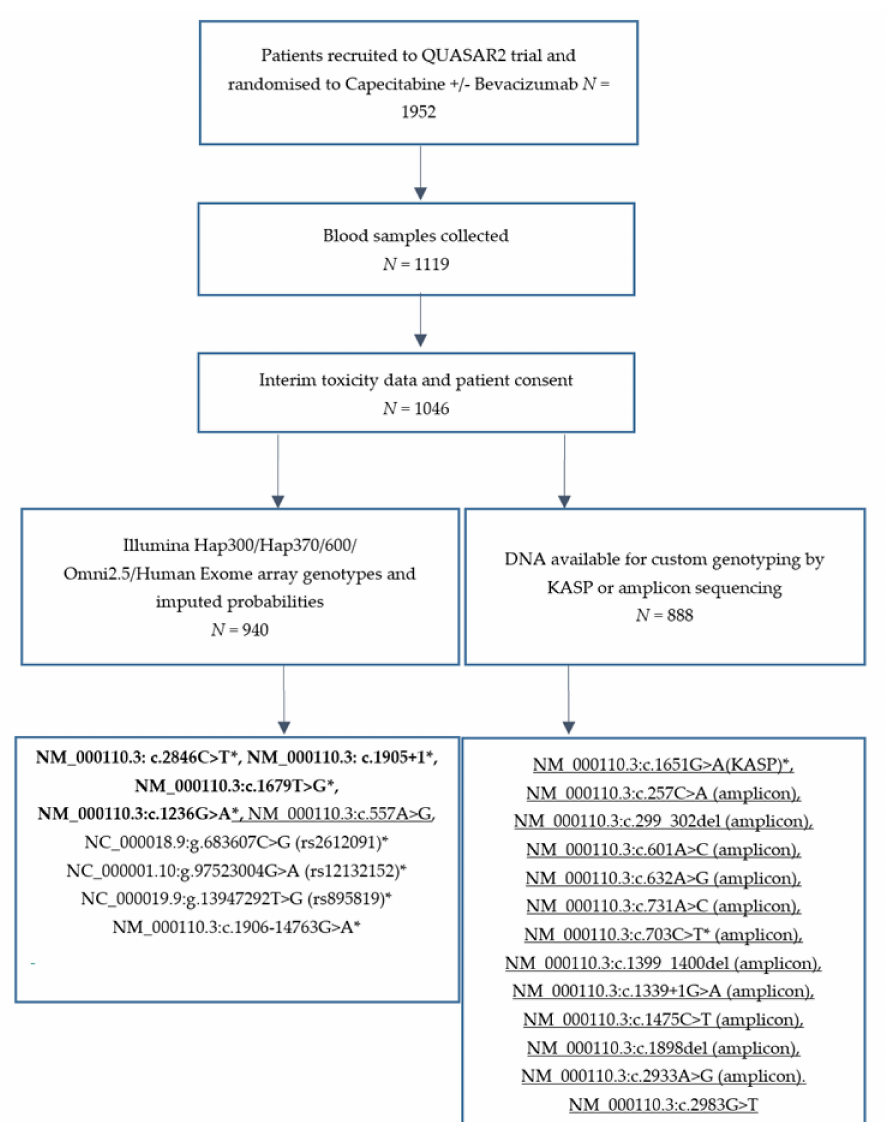
Figure 1. CONSORT diagram showing which QUASAR 2 samples were available for genotyping the variants meeting inclusion criteria 1 and 2. 22 Variants considered for inclusion in the panel are displayed. Those in bold have high quality evidence of a genotype to DPD phenotype in the CPIC 2018 guidelines. Variants that are underlined are the extra DPYD deficiency alleles under consideration based on criteria 2. The remainder are common variants fitting inclusion criteria 1. Those for which at least one variant allele was detected in QUASAR2 are marked with a